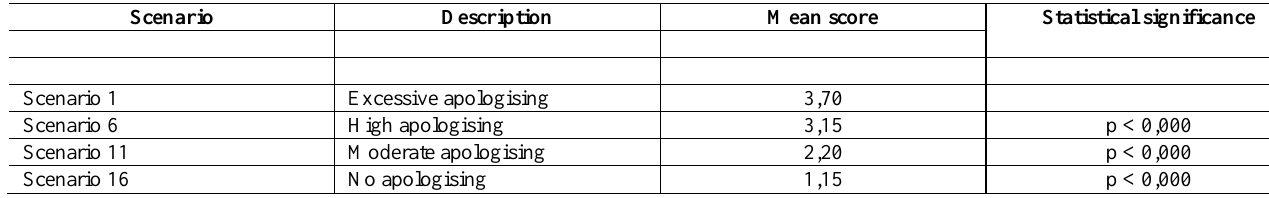
Table 6 : Reliability of satisfaction scores (Chronbach’s